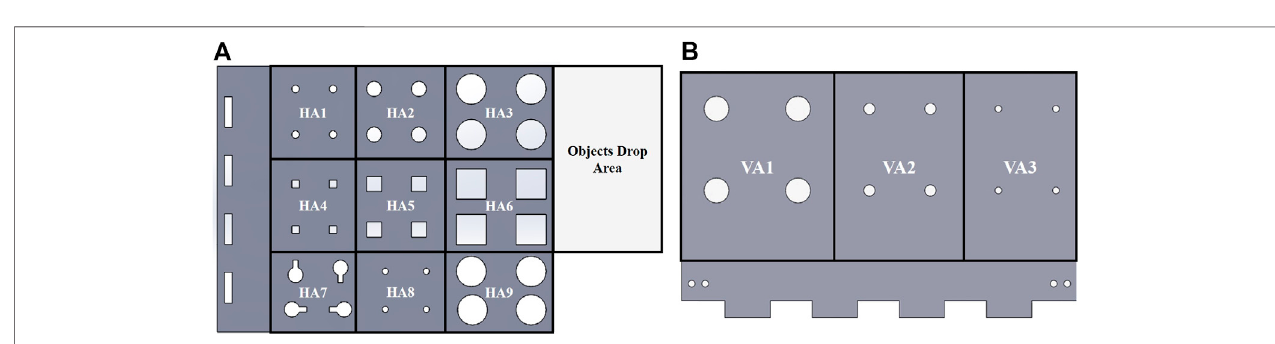
FIGURE 3 | Manipulation regions/areas grouped based on the object being manipulated on: (A) the horizontal rig (HA1 - HA9) and (B) the vertical rig (VA1 - VA3).